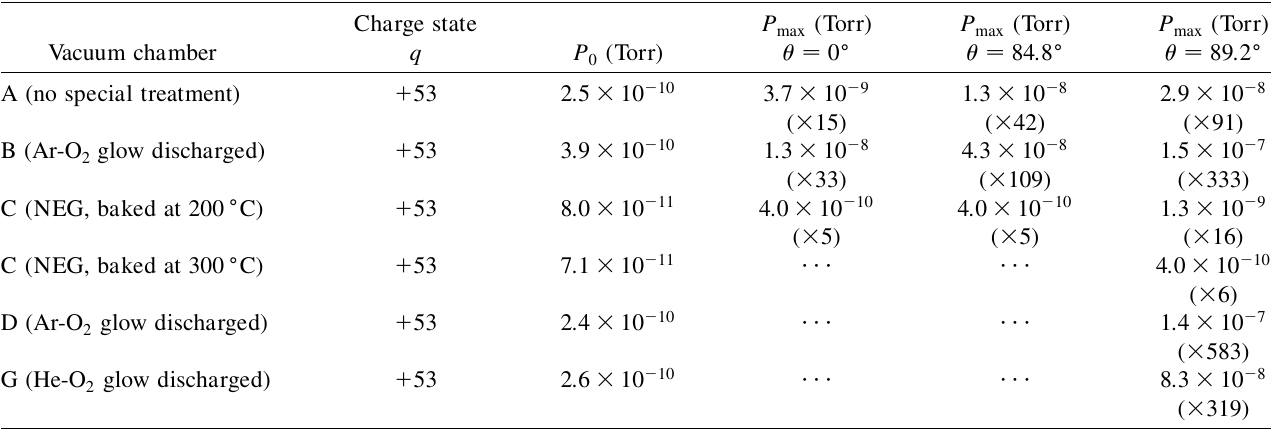
TABLE I. Absolute and relative pressure rises in the test chambers when exposed constantly to shots of 1 : 5 (cid:2) 10 9 Pb 53 (cid:1) ions : base pressure at the beginning of the every 1.2 s for three different impact angles (cid:6) . Normal incidence corresponds to (cid:6) (cid:6) 0 (cid:7) . P 0 : equilibrium pressure under constant ion bombardment. experiments, measured with open sector valve to LINAC 3. P max (Torr) P (Torr) P (Torr) Charge state P max max max Vacuum chamber